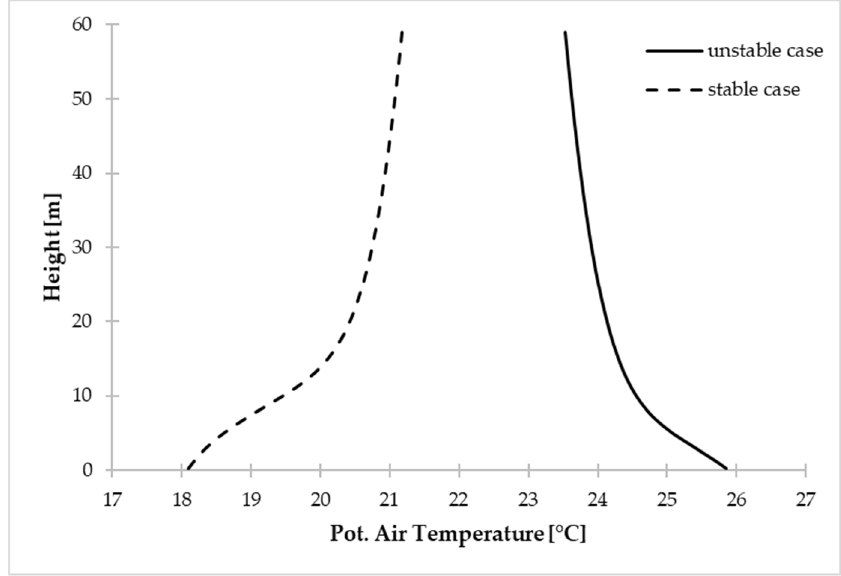
Figure 2. Vertical profile of the potential air temperature at 15:00 h and 03:00 h. To compare the flux footprint results simulated with LaStTraM against the FFP model and the K–M-model, simulations using combinations of different detector heights (3 m, 20 m and 40 m) and atmospheric stabilities (15:00 h unstable case and 03:00 h stable case) were